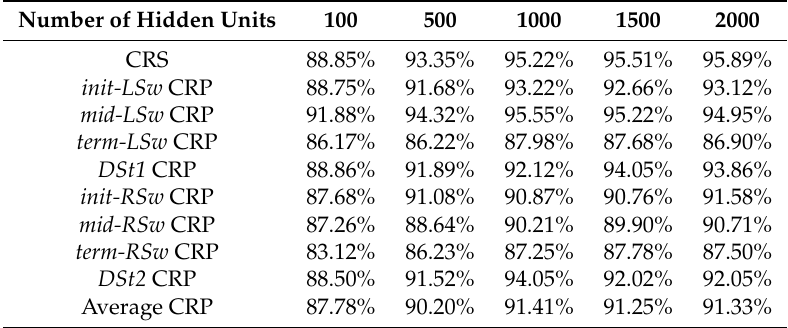
Table 6. The average training set correct rate of set (CRS) and correct rate of phase (CRP) of the gait phase recognition model through 5-fold cross-validation for different numbers of hidden units.